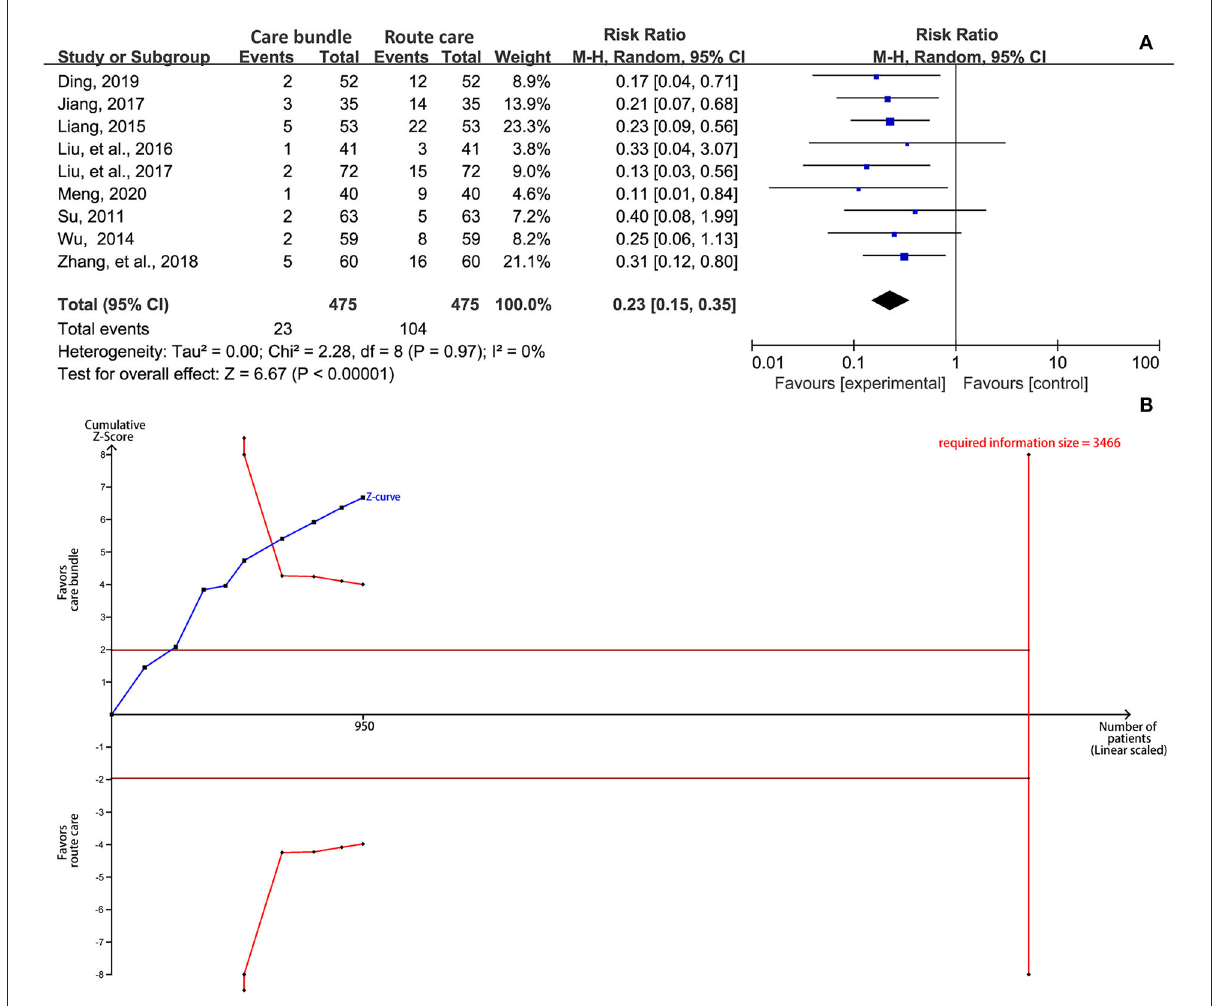
FIGURE4 Synthesis analysis of the incidence of aspiration. (A) forest plot and (B) results of TSA. CI, confidence interval; TSA, trial sequential